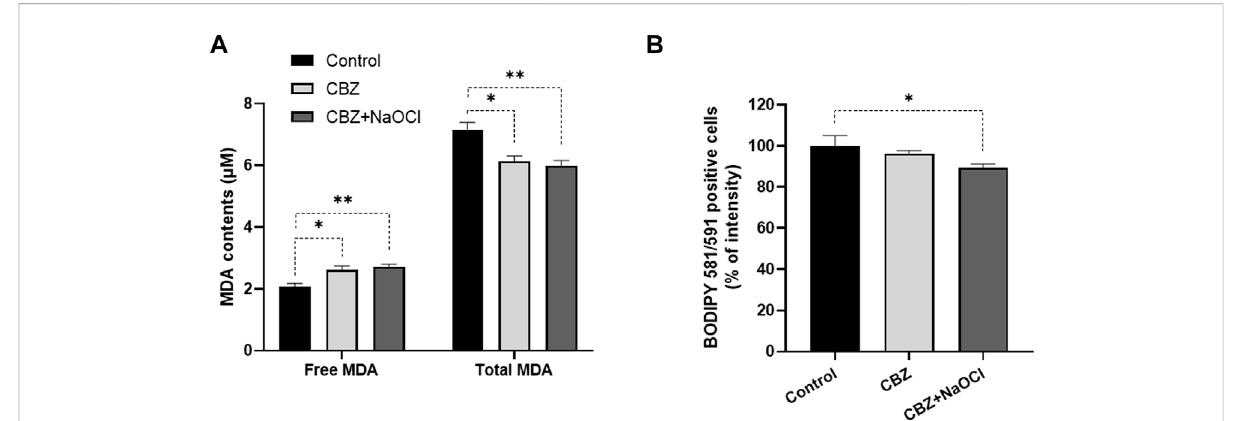
FIGURE 6 Determination of lipid peroxidation in T. obliquus KNUA061 after exposure to CBZ, and NaOCl. Free MDA and total MDA contents (A) , and relative green fl uorescence intensity of BODIPY 581/591 (B) in T. obliquus KNUA061 (* p -value < 0.05, ** p -value <